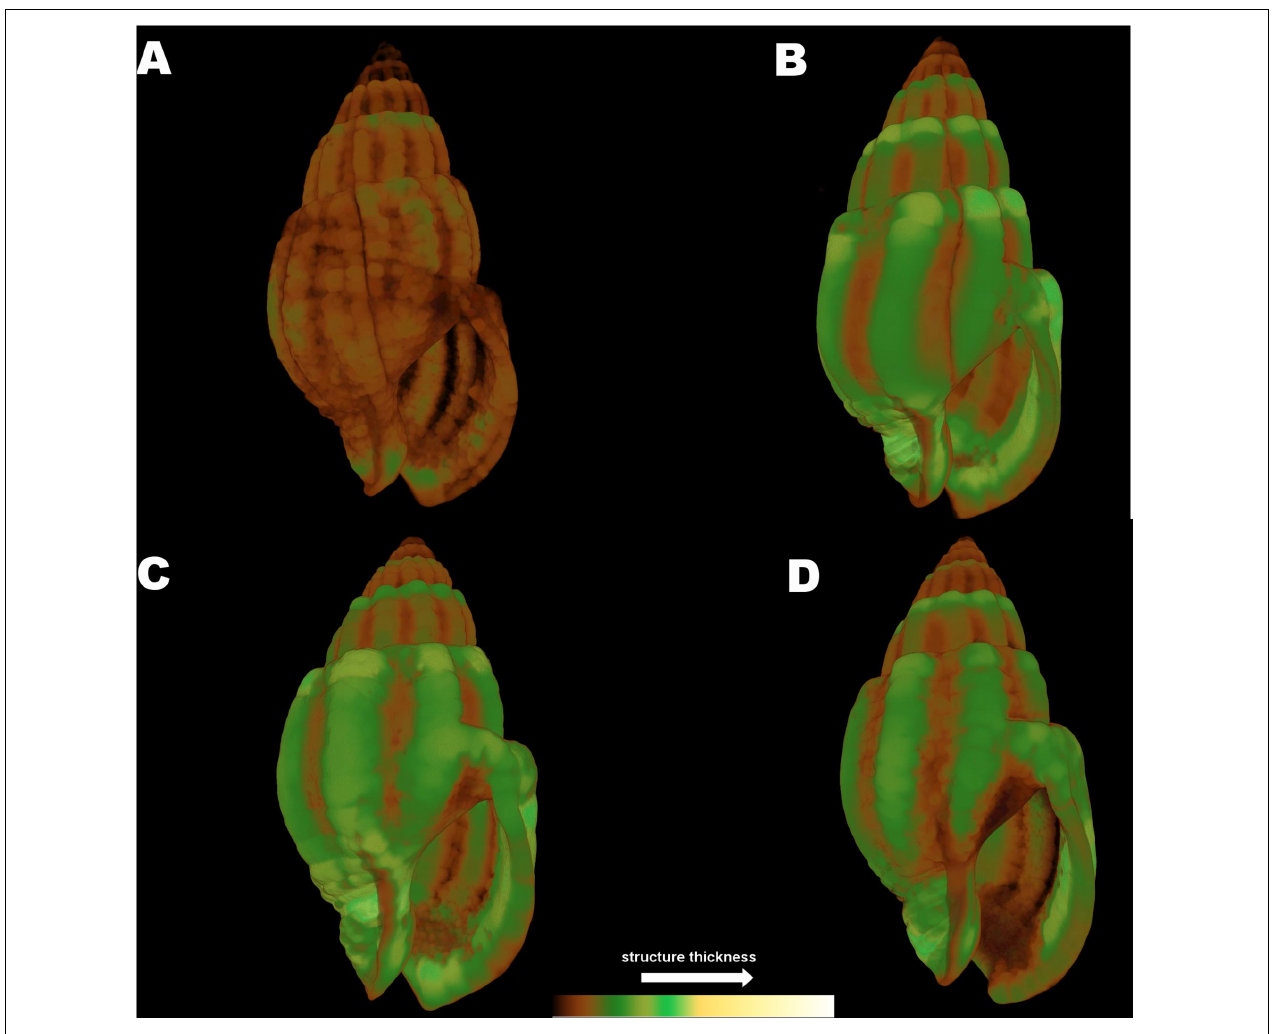
FIGURE 6 | Color coded visualization of shell structure thickness for Nassarius reticulatus in the four experimental treatments (A) (7A), (B) (8A), (C) (7W), and (D) (8W) as coded in the text (8A: 20 ◦ C and pH = 8; 7A: 20 ◦ C and pH = 7.7; 8W: 23 ◦ C and pH = 8; 7W: 23 ◦ C and pH = 7.7). The bar on the bottom of the image indicates thickness scaling (cooler colors indicate thicker structures, warmer colors indicate thinner